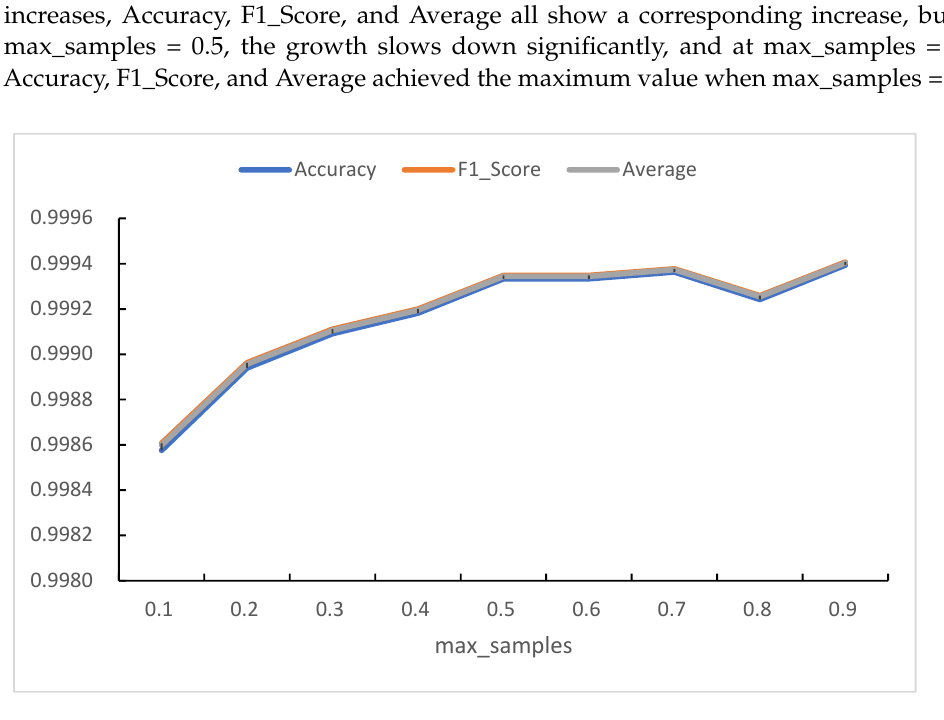
Figure 14. max_samples optimizes predict_time.